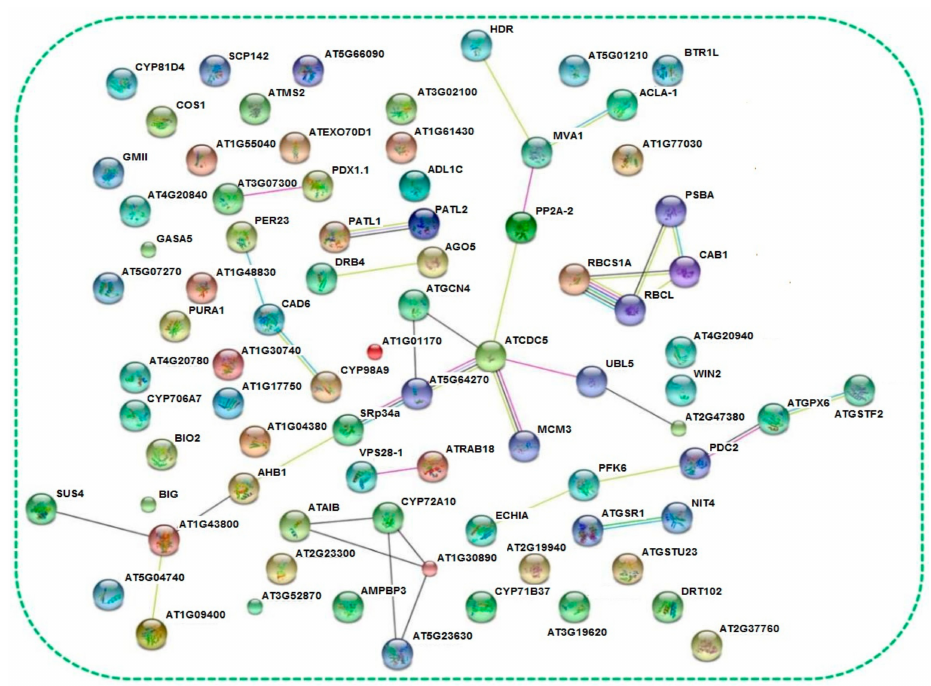
Figure 5. String network of the di ff erential proteins identified based on Arabidopsis thaliana